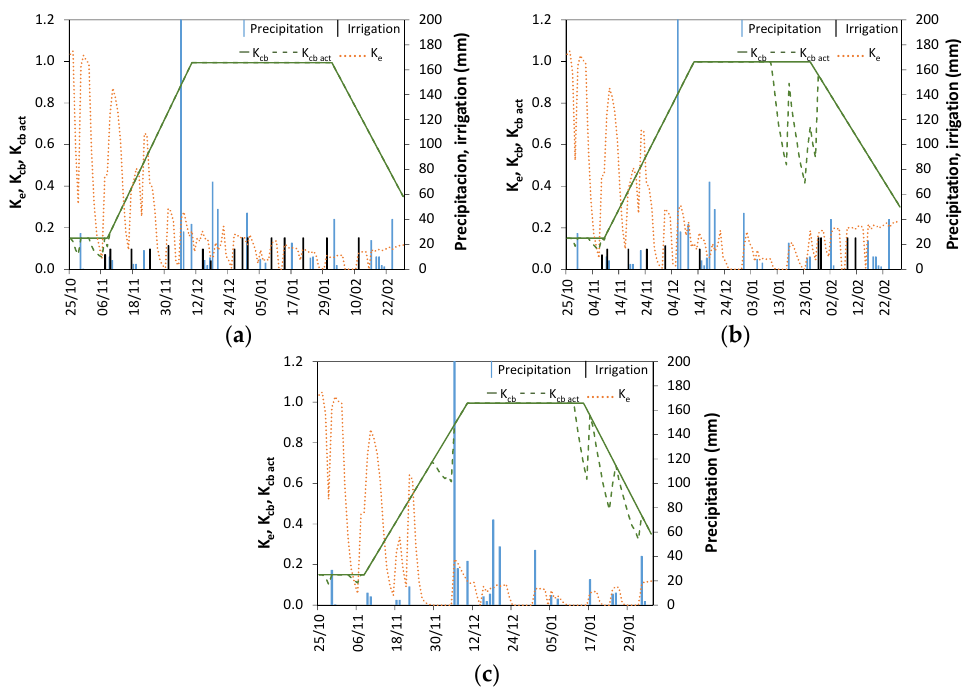
Figure 4. Seasonal variation of the coefficients K cb , K cb act , K e , including net irrigation and precipitation for the following experimental conditions in 2012–2013: ( a ) FI; ( b ) DI FLO ; and ( c ) rainfed.